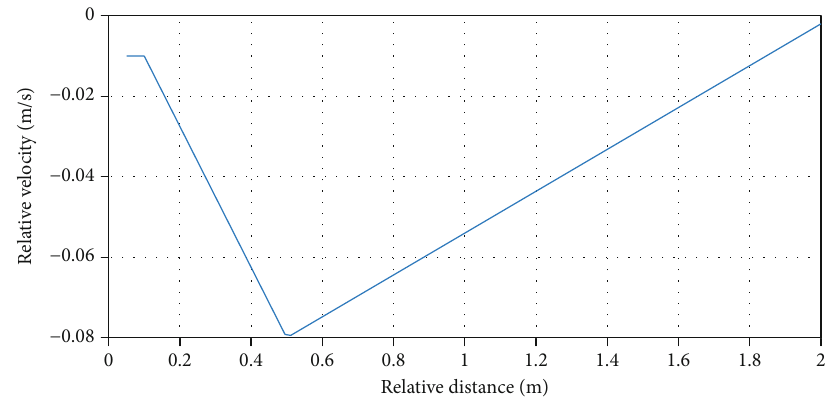
Figure 12: Docking trajectory